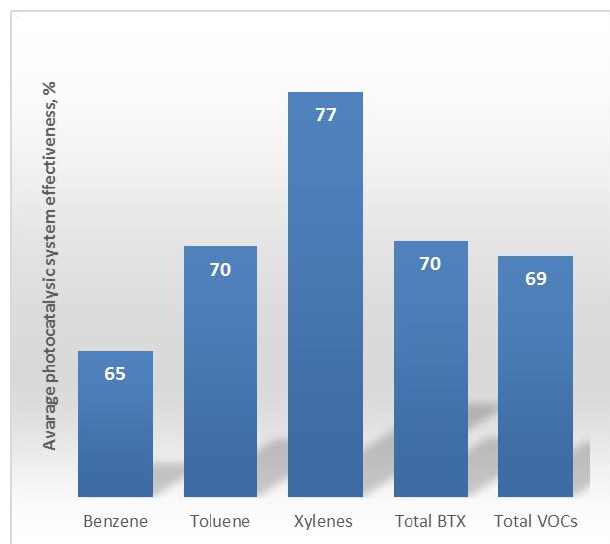
Fig. 3. Average photocatalytic system effectiveness, temperature 290 K